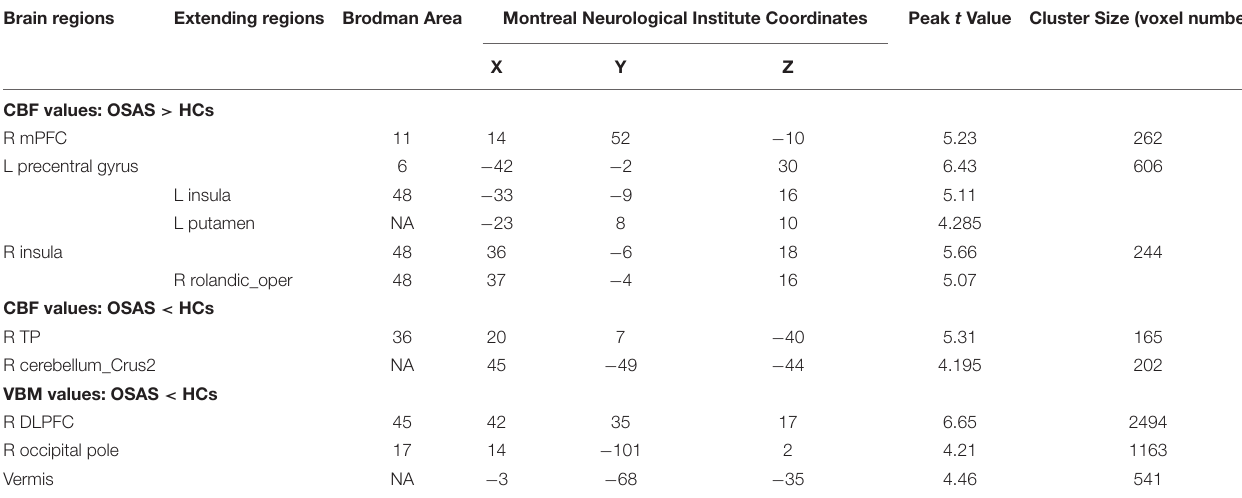
TABLE 2 | The areas of significantly different CBF and VBM values between the OSAS patients and the HCs. ( p < 0.001, cluster level p < 0.05, cluster > 165, FWE corrected). Brain